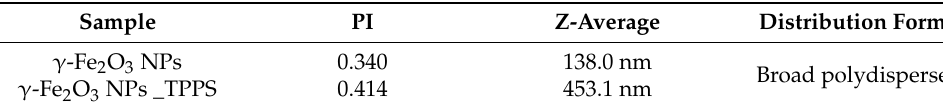
Table 2. The mean hydrodynamic size of the samples.